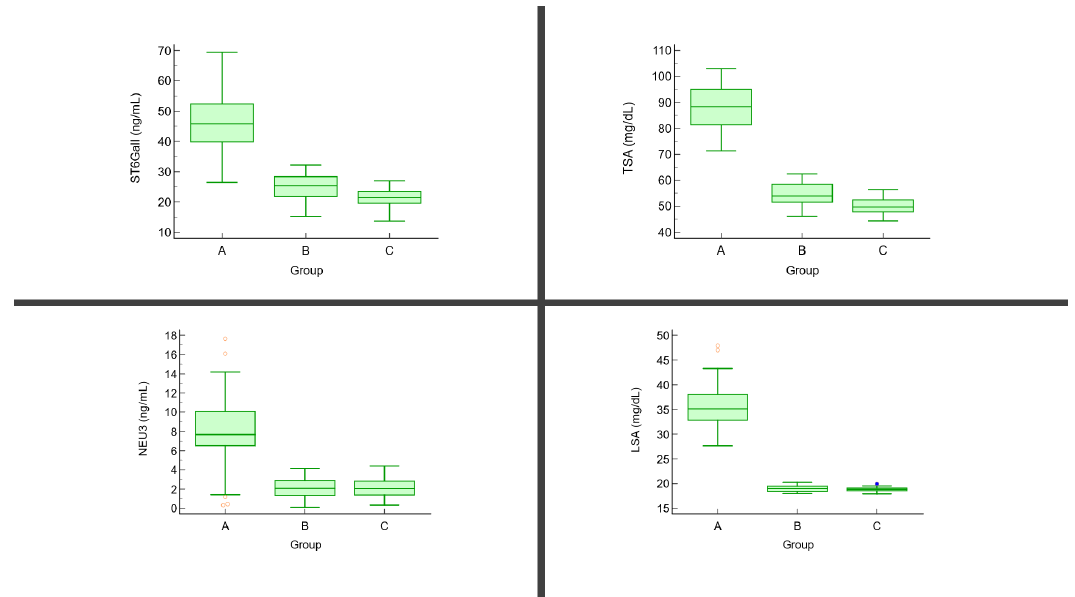
p -significance level, p *—triple comparison of the groups, p **—pairwise comparison of the groups.